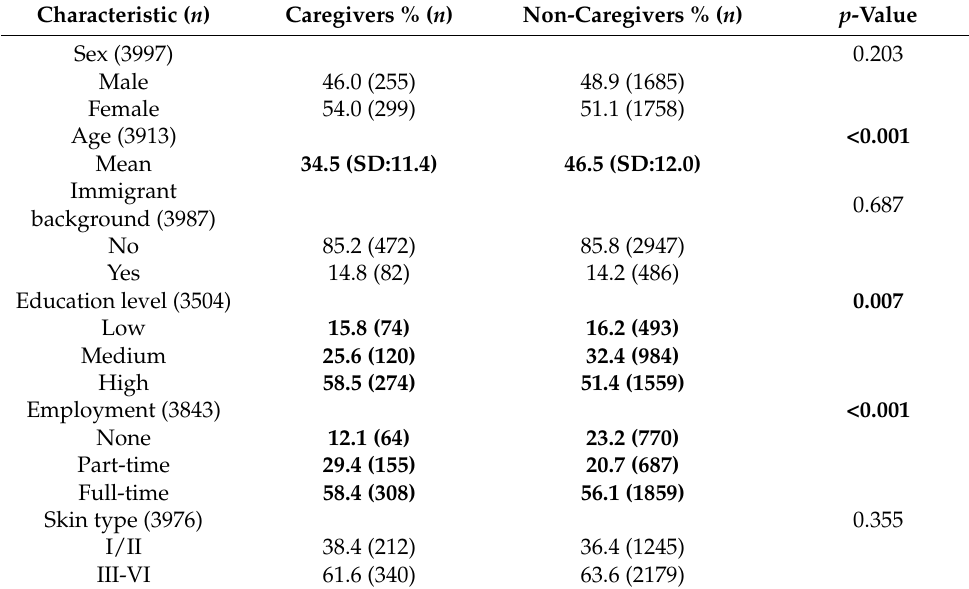
Table 1. Sociodemographic characteristics of caregivers compared to non-caregivers.